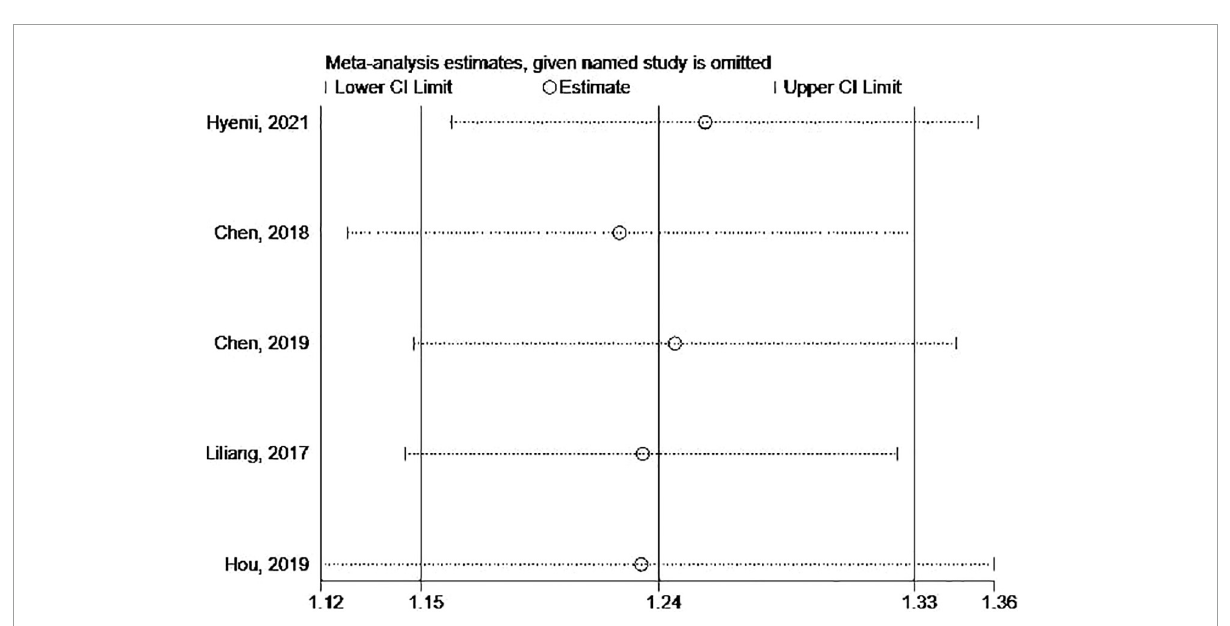
FIGURE3 The funnel plot for dementia.